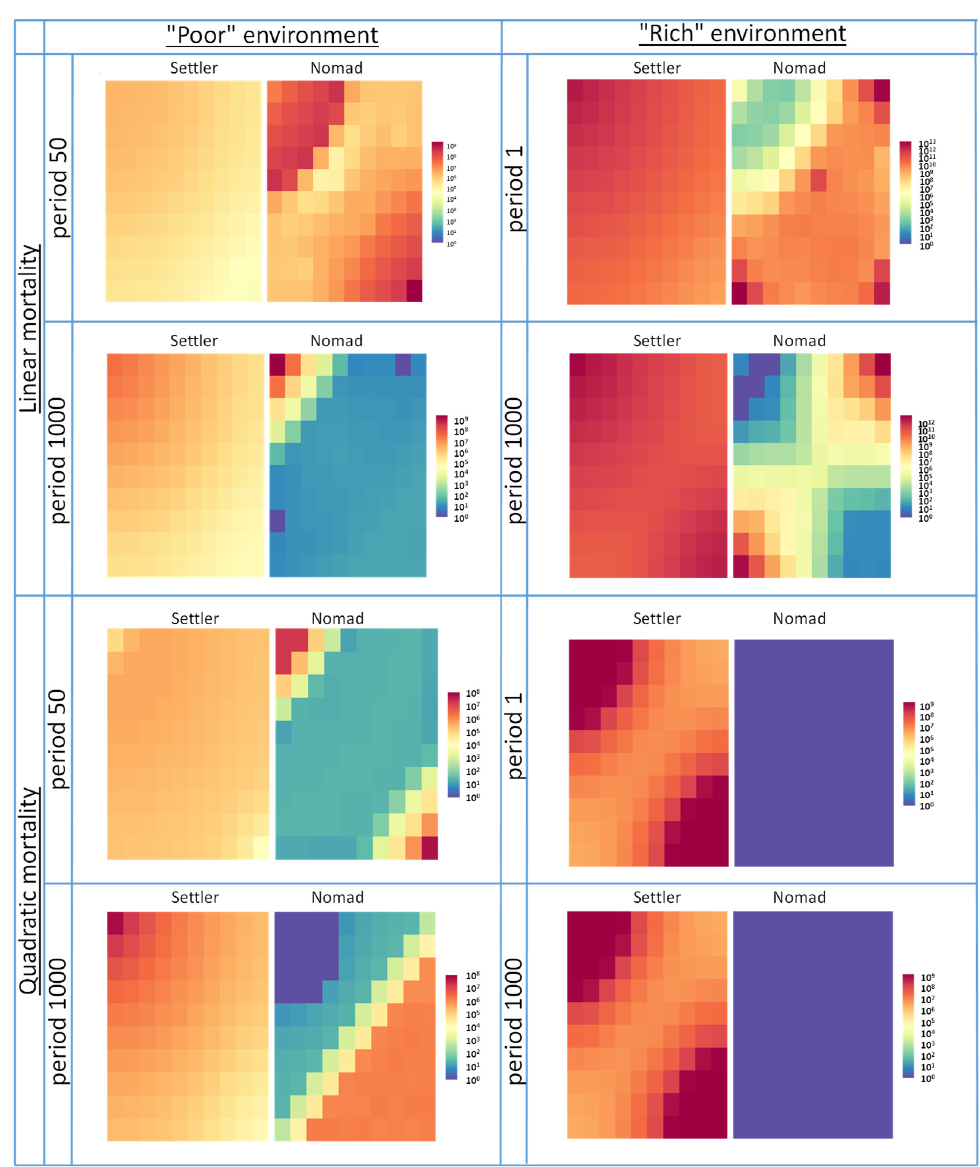
Figure 3. Heatmaps of spatial dispersion snapshots of Settler and Nomad cells in the habitat taken at the end of the simulation run under various simulation scenarios. The heatmap scale represents the abundance measured in the number of cells. The “start” nutrient source is located in the upper-left corner while the “distant” source is located in the opposite bottom-right corner.